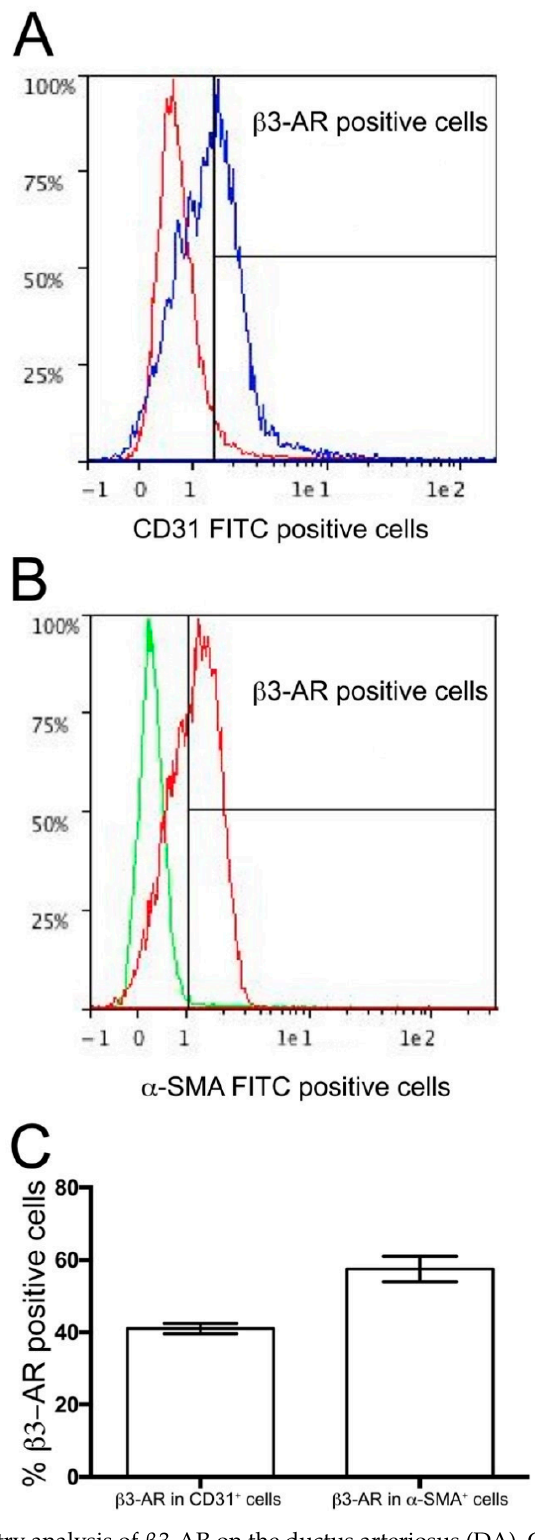
Figure 4. Flow cytometry analysis of β 3-AR on the ductus arteriosus (DA). Cytofluorimetric plot of β 3-AR positive cells in CD31 positive cells (blue plot) (Panel A ) and β 3-AR positive cells in α -SMA positive cells (red plot). (Panel B ). About 40% of endothelial cells and 55% of smooth muscle cells are positive for β 3-AR (Panel C ). Results were reported as mean ± SD and are representative of three independent